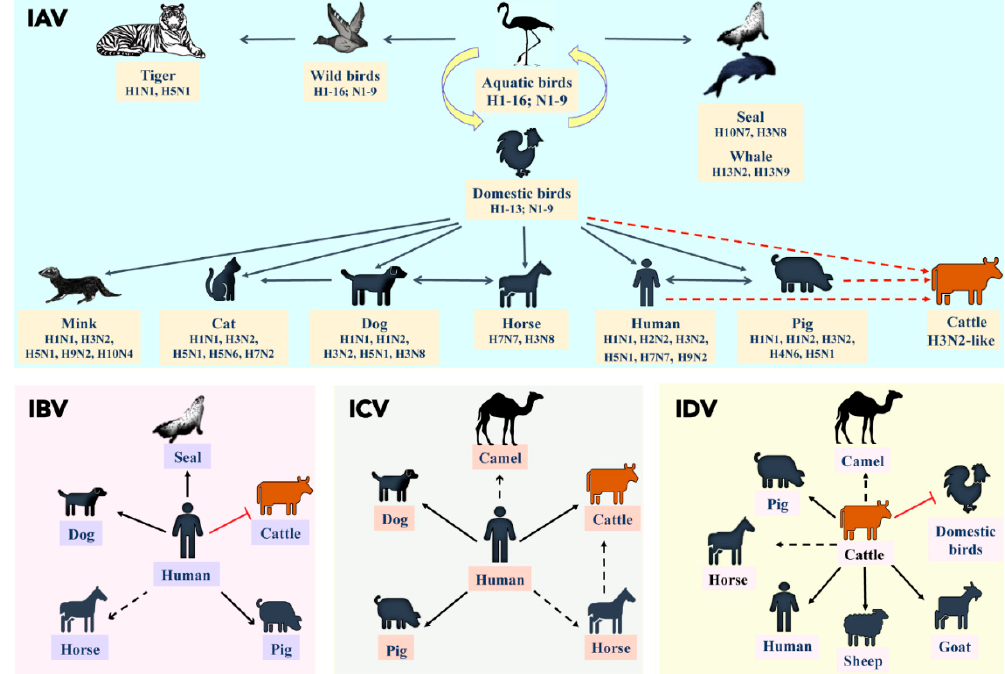
Figure 2. The host range for all four types (IAV, IBV, ICV, and IDV) of influenza viruses. The association of influenza disease in different mammalian species with reference to cattle (orange) is described separately. In each box, the bold black line represents active infection/disease; dotted black line represents the exposure without active infection/disease, as demonstrated by the serological evidence. A red dotted line in IAV indicates the possible source/routes of IAV infection (human, avian or swine) that can occur in bovines. Red blocked line indicates neither disease nor exposure. Vector graphic images used in the figure were taken from icon pool of the Microsoft Office and Freepik (www.freepik.com).